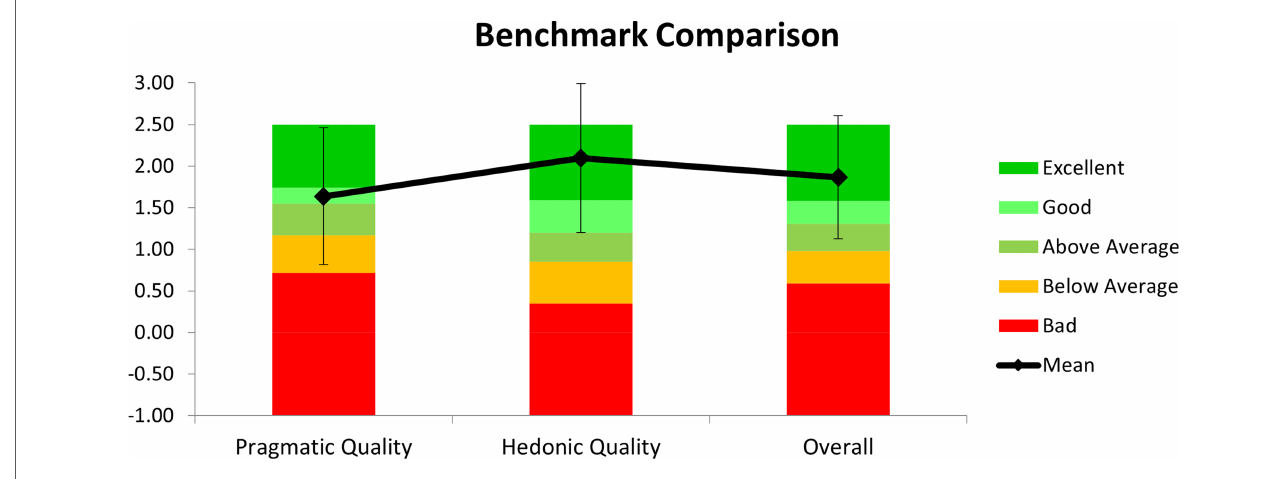
FIGURE 7 User experience questionnaire qualities results and benchmark.